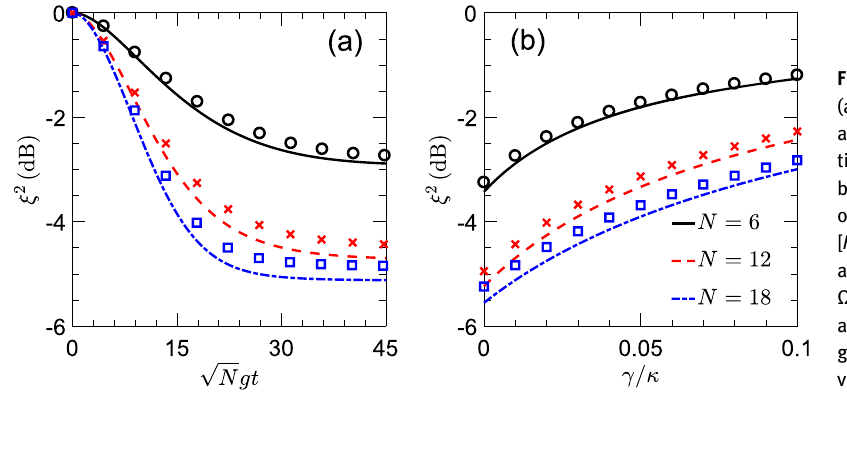
Figure A1: Spin squeezing parameter ξ 2 . (a) shows the time evolution for γ (cid:2) 0 . 01 κ , and in (b) the ratio γ / κ is varied at a fi xed (cid:7)(cid:7) √ time N gt (cid:2) 45, for N = 6, 12, and 18. In both plots, curves and symbols are results obtained using the effective ( H eff ) and full [ H ( t )] Hamiltonians, respectively. We have assumed that g (cid:2) 0 . 5 κ , Δ c (cid:2) 200 κ , Ω (cid:2) 0 . 2 Δ (cid:2) 0 . 34 ω γ (cid:2) 0 . 01 κ , and c , A m m , also that all atoms are initialized in the ground state and the cavity is in the